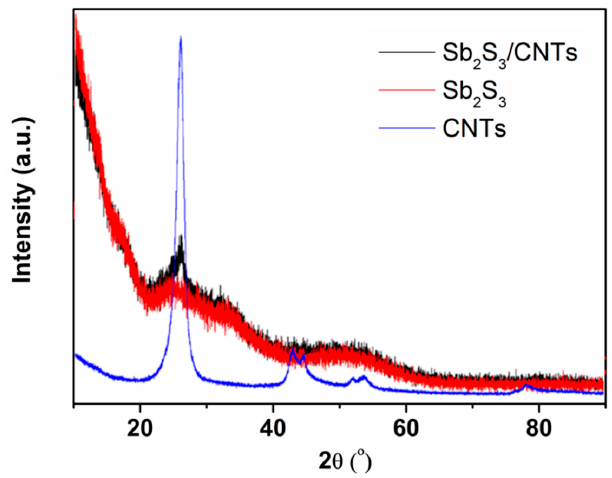
Figure 1. XRD patterns of the as-prepared Sb 2 S 3 / carbon nanotube (CNT) nanocomposites, pure Sb 2 S 3 and CNTs.